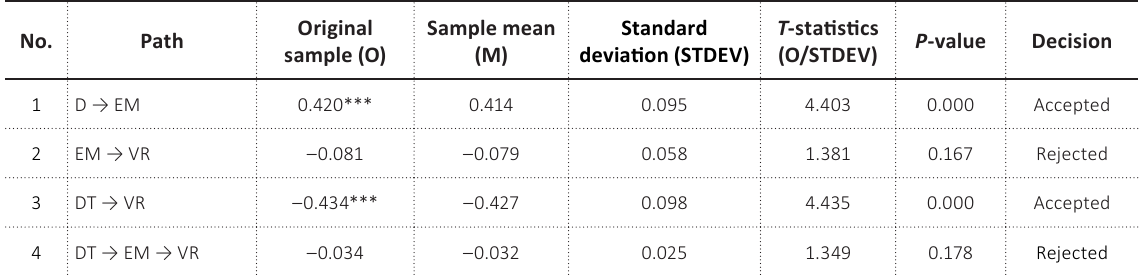
Table 7. Path coefficient